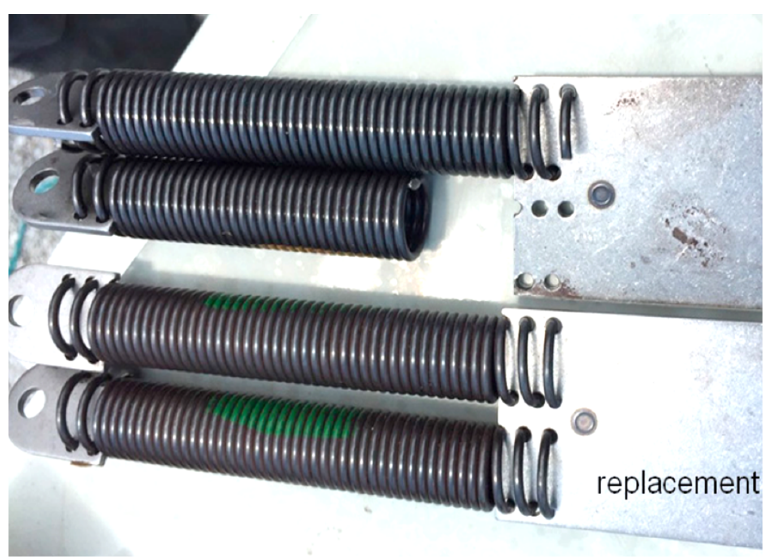
Figure 5. Broken energy accumulator spring [13].